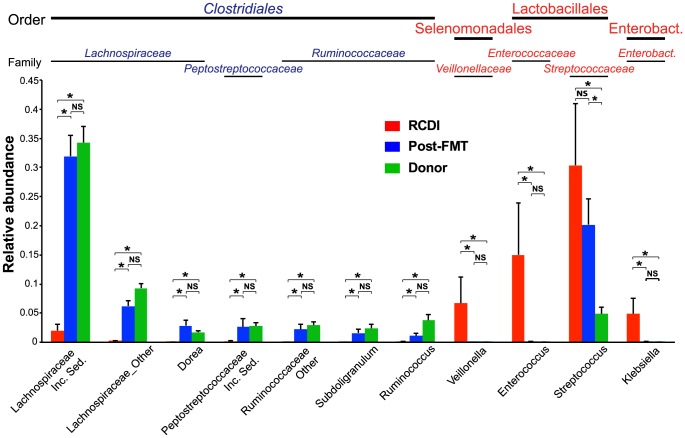
Microbiota changes between RCDI and post-FMT patient and healthy donor sample groups at the taxonomic family and genus levels.Significant differences between sample groups as calculated with the Metastats tool are marked with asterisks (p<0.01). Note that standard deviations are smaller for genera that increased in post-FMT relative to RCDI patient samples (e.g., Lachnospiraceae Incertae Sedis) compared to those that decreased (e.g. Streptococcus), which reflects differences in the relative abundances of major microbiota members among RCDI patient samples.